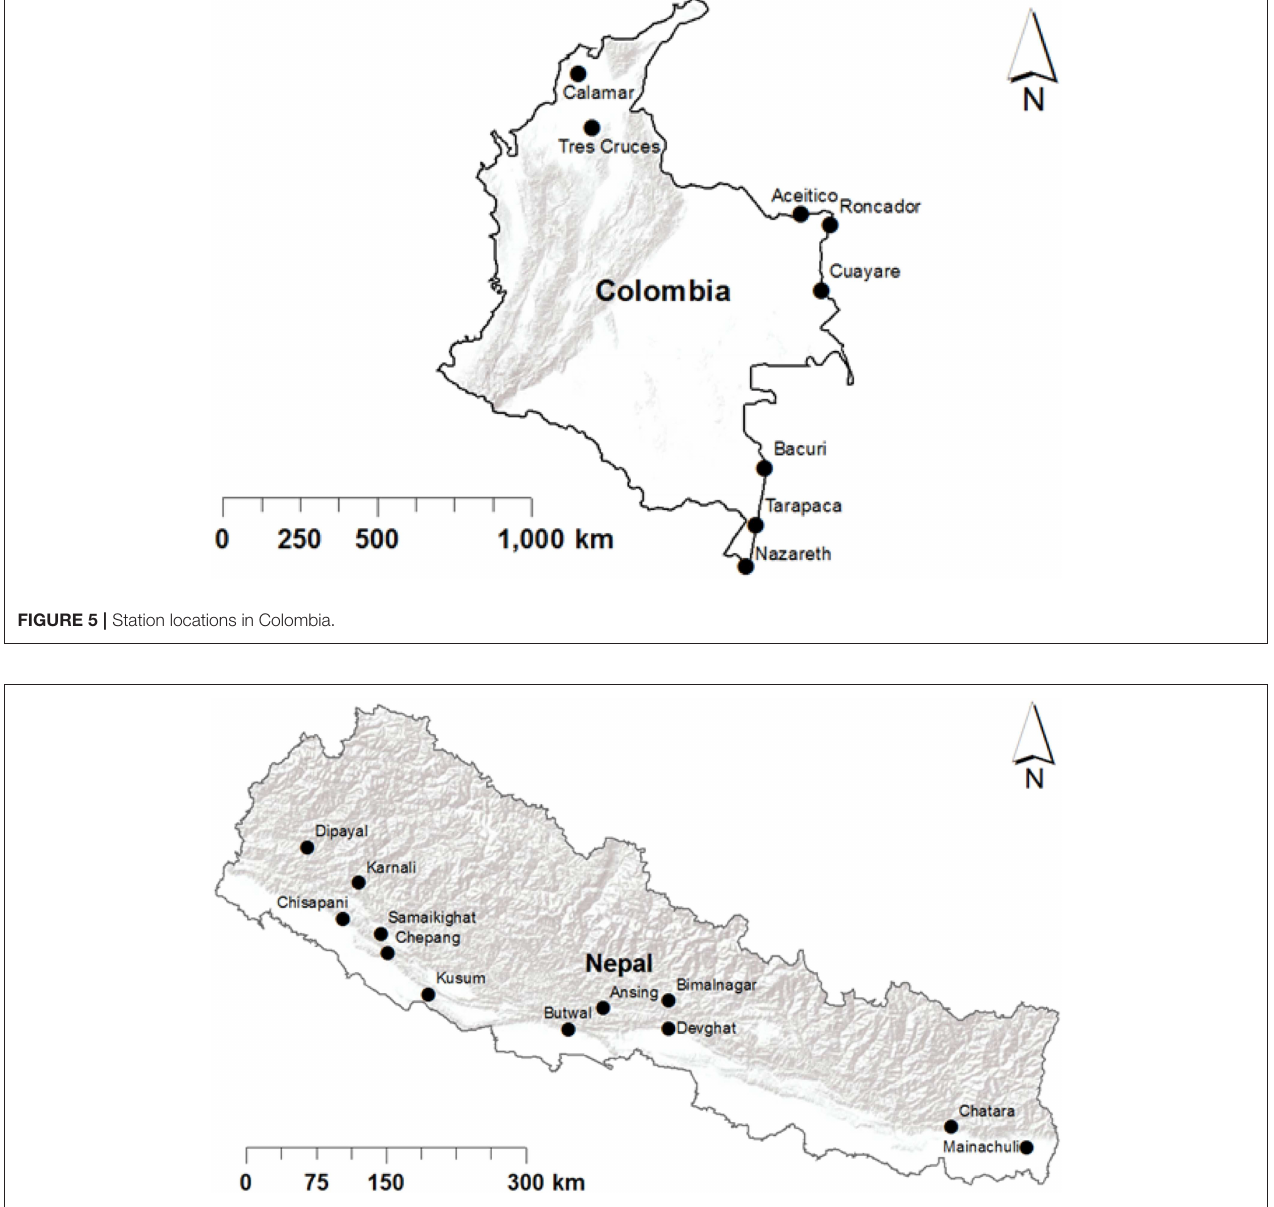
FIGURE 6 | Station locations in